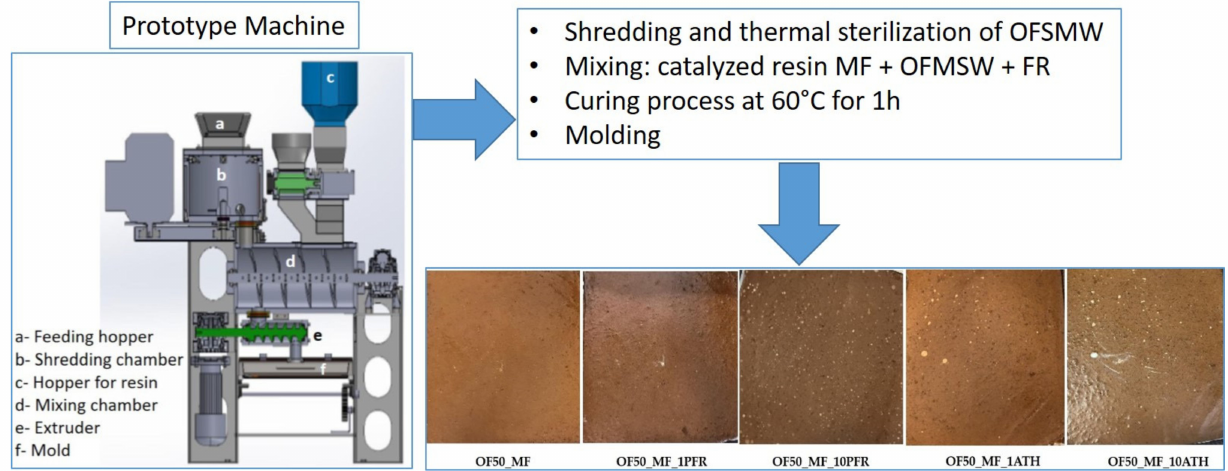
Figure 1. Representative scheme of the production of the experimental panels and pictures showing the top surface of each realized